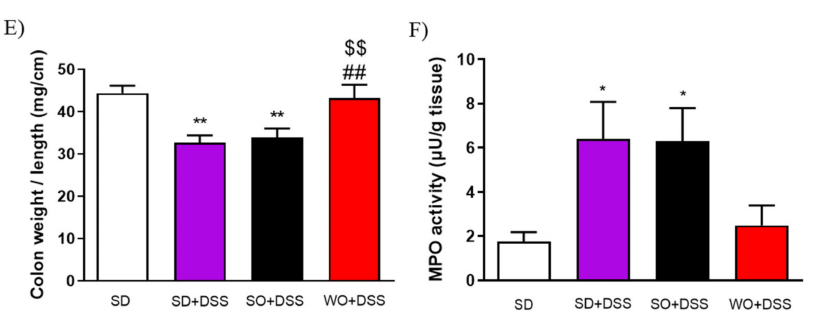
Figure 3. The anti-inflammatory e ff ect of sunflower oil (SO) and walnut oil (WO) in a mouse model of colitis induced by DSS. Figure shows the data for macroscopic score ( A ), stool score ( B ), colon length ( C ), colon weight ( D ), colon weight / colon length ratio ( E ), and myeloperoxidase (MPO) activity ( F ). Data represent mean ± SEM, n = 8. * p < 0.05, ** p < 0.01, *** p < 0.001, as compared to control; # p < 0.05, ## p < 0.01, ### p < 0.001 as compared to DSS; $$ p < 0.01, as compared to sunflower oil